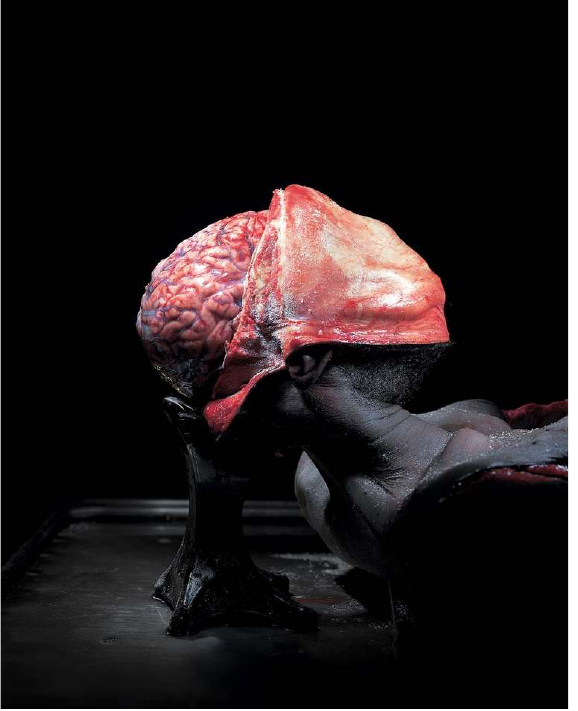
Figure 2: Brain surgery. Max Aguilera-Hellweg, The sacred heart, an atlas of the body series ,